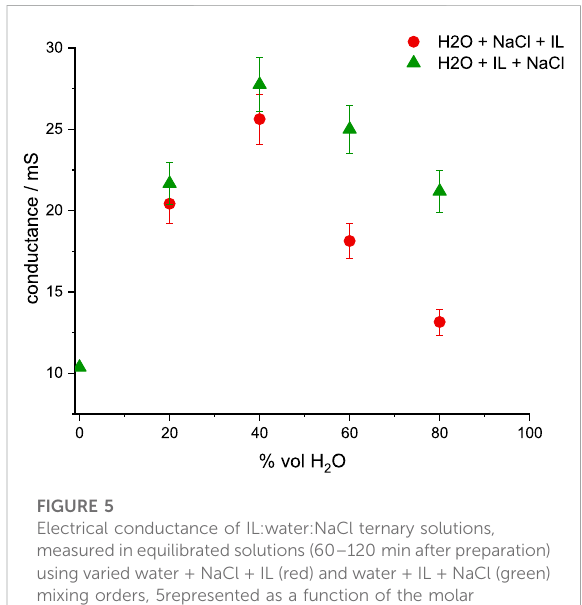
FIGURE 5 Electrical conductance of IL:water:NaCl ternary solutions, measured in equilibrated solutions (60 – 120 min after preparation) using varied water + NaCl + IL (red) and water + IL + NaCl (green) mixing orders, 5represented as a function of the molar fraction of water ( X water